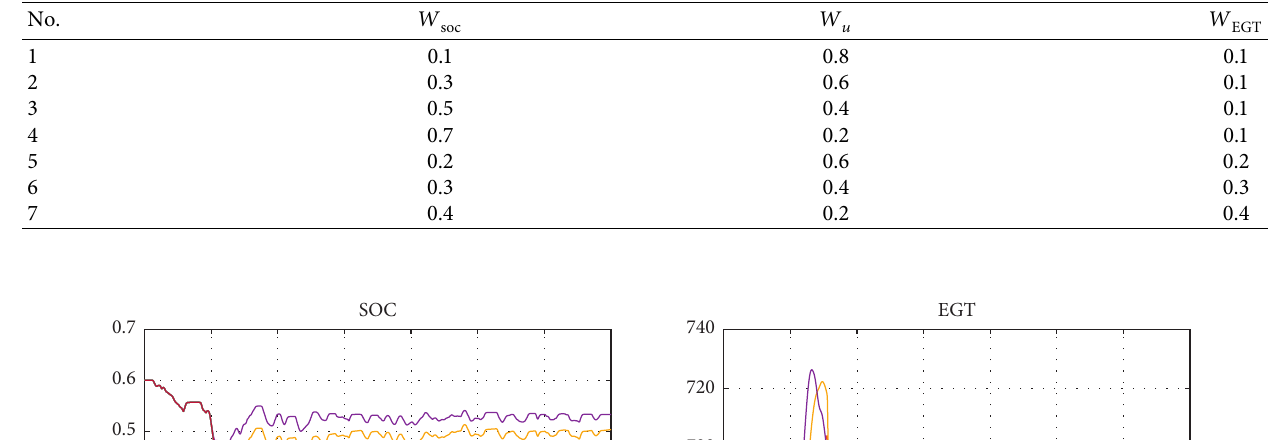
Table 7: Configuration of weight coefficient.